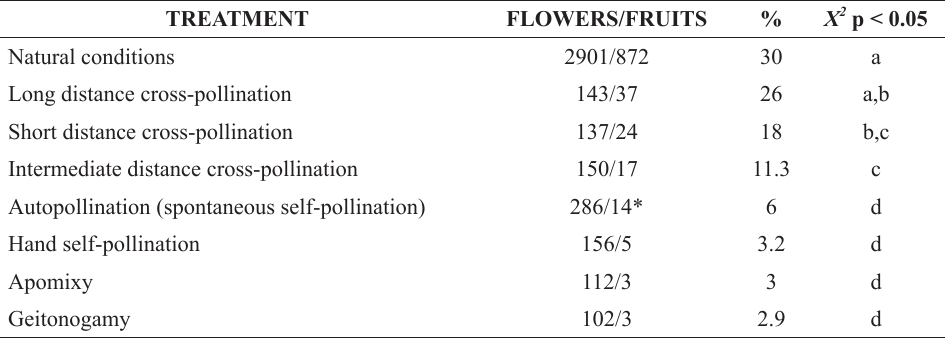
Proportion between formed fruits and flowers used in controlled treatment applied in Byrsonima cydoniifolia and chi-square test ( X 2 ) with statistical differences among the types of pollination treatment in Pantanal sub-region of Miranda, Mato Grosso do Sul,